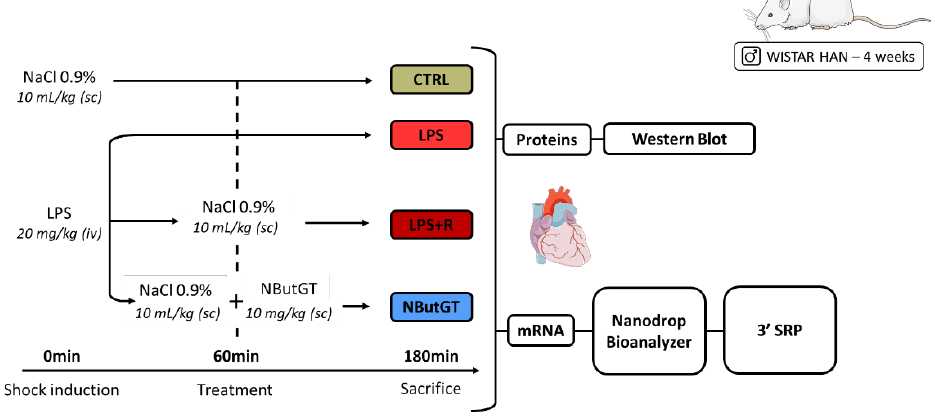
Figure 6. Model of endotoxemic shock in the young rat and analyses performed . CTRL: control group; LPS: i.v., injection of LPS (20 mg/kg); LPS + R: s.c. administration of 10 mL/kg of NaCl 0.9%; NButGT: fluidotherapy supplemented with NButGT (10